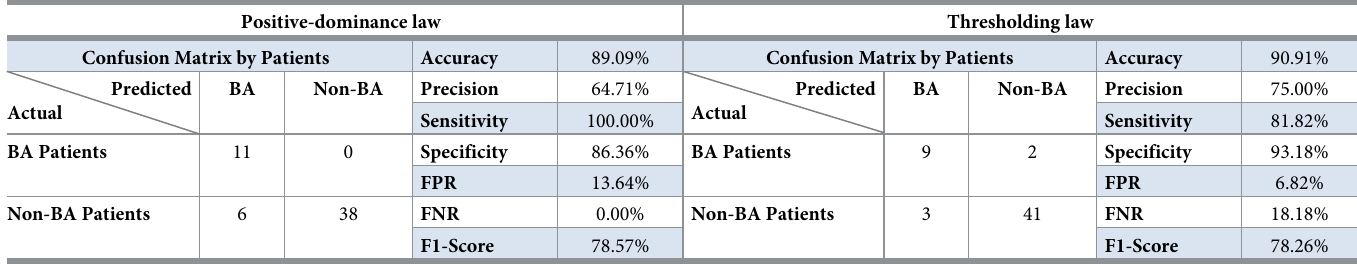
Table 4. Confusion matrix and execution results of test set by ShuffleNet obeying different laws of interpretation.